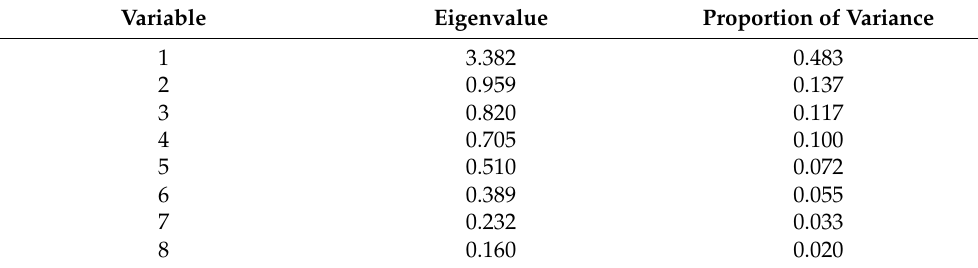
Table 3. Items explained variance based on